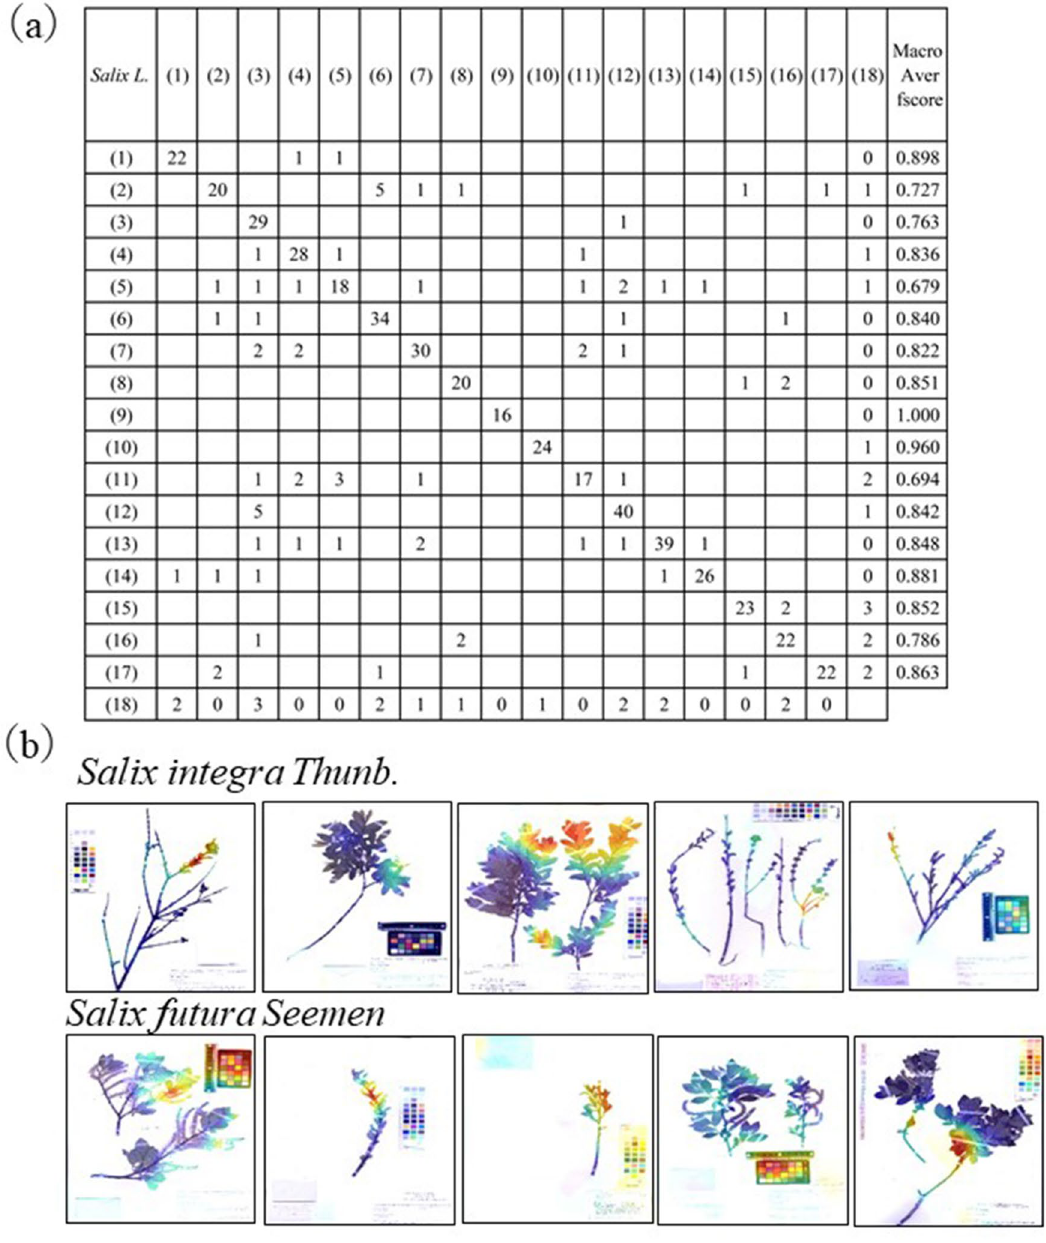
apical part of lamina. For P. tripteron 1,320 of the 1,381 images (95.5%) focused on the long, cross-shaped basal pinnae. Using Grad-CAM, we identified the parts of the image that are important for AI identification. First, we investigated the Grad-CAM analysis results and selected 287 images that were identified by focussing on a